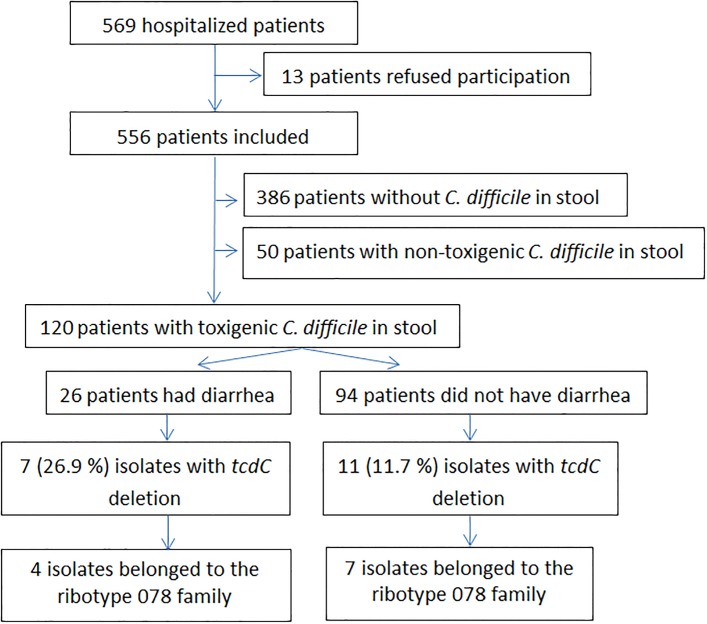
Flowchart of the patients enrolled in this study.